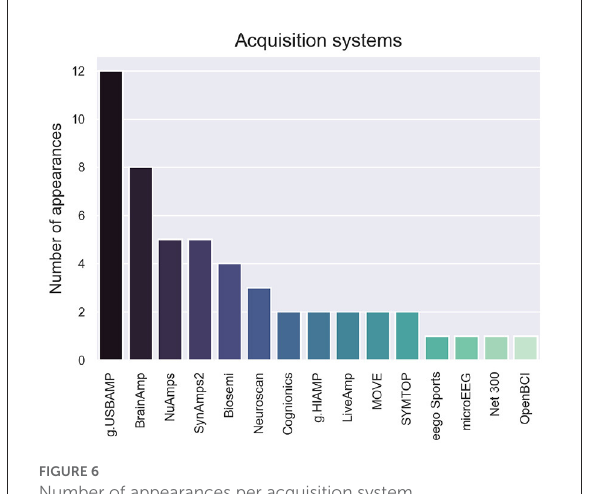
FIGURE6 Number of appearances per acquisition system.